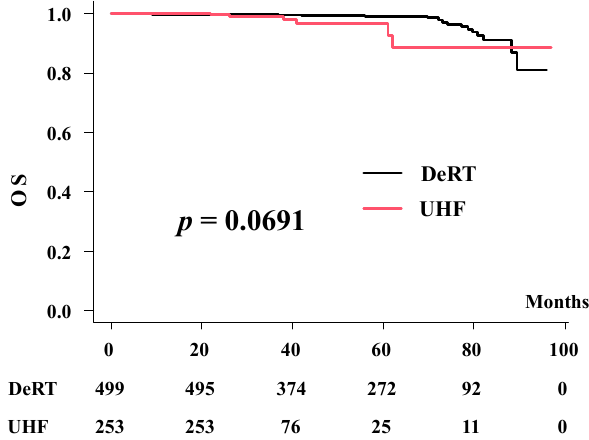
Figure 3. Overall survival rates between UHF and DeRT.